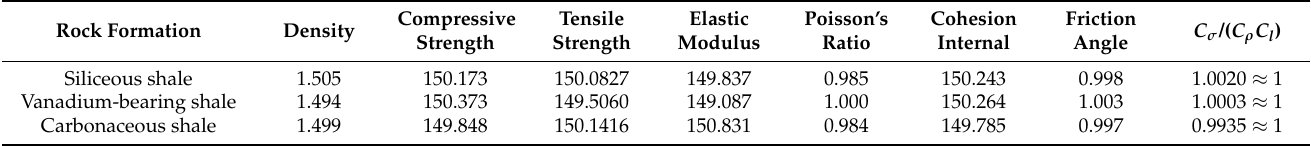
Table 12. Similar constants of similar